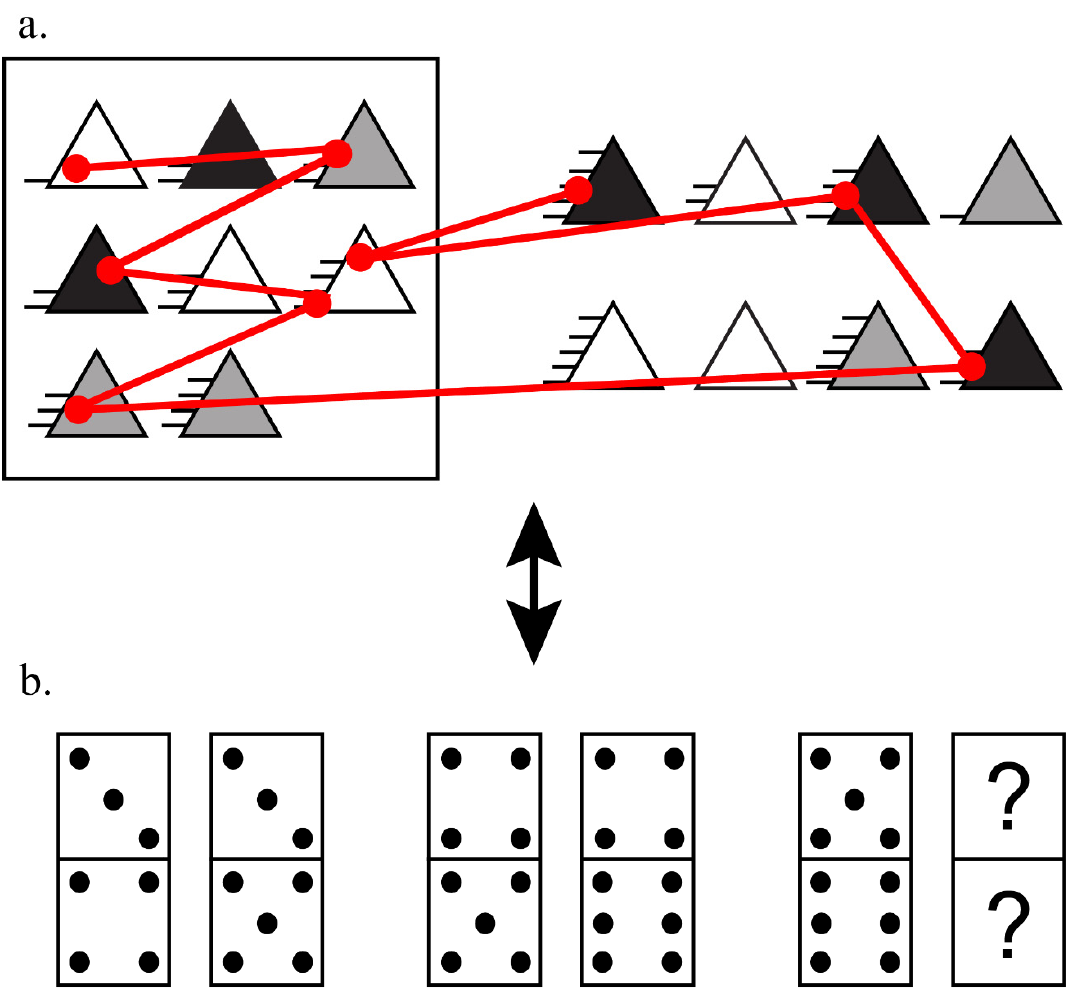
Figure 1. ( a ) Sample problem based on the WMT-2 task overlaid with a schematic representing an eye gaze pattern in red. Circles represent fixation locations, and lines represent eye movements, or saccades, between fixations; ( b ) sample problem on the D.70 test with the missing domino piece described as “?”.